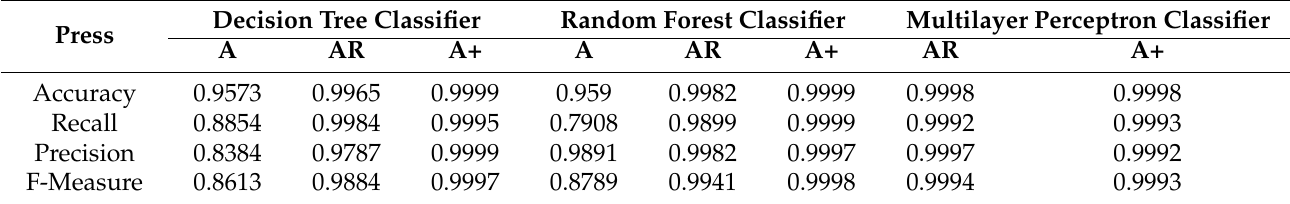
Table 5. Results for the ironing press. With “A” we refer to the experiments that used only active power. With “AR” we refer to experiments with active and reactive power and with “A + ” we refer to experiments with all the selected attributes. Press